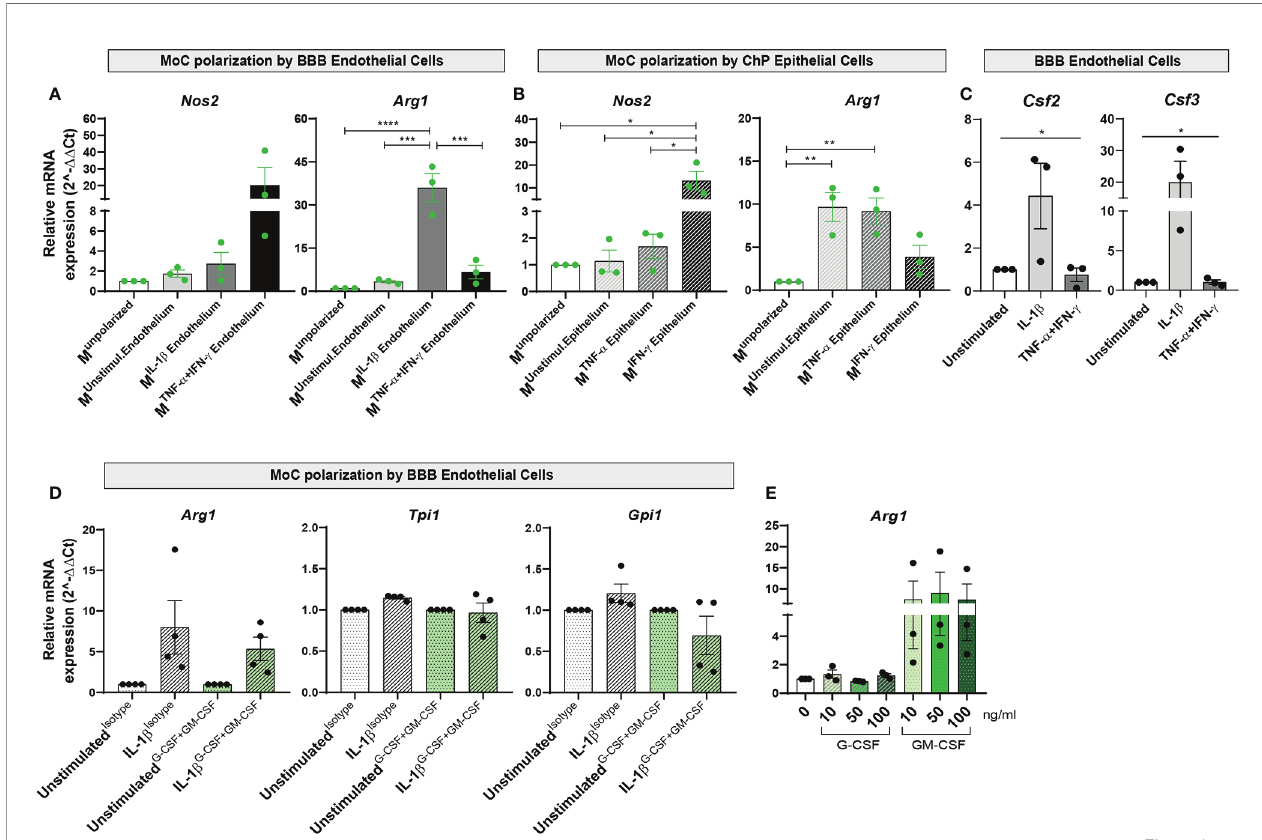
FIGURE 4 | Interaction with BBB endothelial and ChP epithelial cells drives functional speci fi cation in MoCs. Relative mRNA expression of Nos2 and Arg1 genes in M unpolarized MoCs following 7h incubation with (A) BBB endothelial cells and (B) ChP epithelial cells. (A) Incubation with TNF- a +IFN- g BBB endothelial cells led to Nos2 upregulation in MoCs (M unstimul.Endothelium Mean = 1.74, SEM = 0.37; M IL-1 b Endothelium Mean = 2.74, SEM = 1.12; M TNF- a +IFN- g Endothelium Mean = 20.26, SEM = 10.6). In contrast, Arg1 relative mRNA expression was signi fi cantly increased in MoCs incubated with IL-1 b BBB endothelial cells (M IL-1 b Endothelium ) as compared to M unpolarized cells (p < 0.0001), to M unstimulated Endothelium (p = 0.0001) and M TNF- a +IFN- g Endothelium (p = 0.0003). (B) MoCs incubated with IFN- g stimulated ChP epithelial cells (M IFN- g Epithelium ) signi fi cantly upregulated Nos2 relative mRNA expression compared to M unpolarized (p = 0.013), to M unstimulated Epithelium (p = 0.014) and to M TNF- a Epithelium (p = 0.018). Similarly, MoCs incubated with unstimulated ChP epithelial cells (M unstimulated Epithelium) (p = 0.007) or with TNF- a ChP epithelial cells (M TNF- a Epithelium ) (p = 0.01) displayed increased Arg1 mRNA expression. (C) mRNA expression of Csf2 and Csf3 in BBB endothelial cells. Following 16h of IL-1 b stimulation, BBB endothelial cells displayed a signi fi cantly increased Csf2 (one way ANOVA – F (2,6) = 8.97, p = 0.02) and Csf3 relative mRNA expression (one way ANOVA – F (2, 6) = 5.203, p = 0.05) compared to unstimulated and TNF- a +IFN- g BBB endothelial cells. The relative mRNA expression of Nos2 and Arg1 was calculated based on the 2 - DD Ct method using S16 (A, B) or Hprt (C) as reference genes. Data is presented as fold increase relative to M unpolarized condition (A, B) or to unstimulated condition (C) ; displayed are means and SEM from three individual experiments, *p < 0.05, **p < 0.01, ***p < 0.001, ****p < 0.0001. A mean of the raw cycle threshold (Ct) values from the independent experiments performed are provided in Supplementary Table 3 and 4 . (D) mRNA expression of Arg1 , Tpi1 and Gpi1 genes in MoCs following 7h incubation with BBB endothelial cells or ChP epithelial cells in the presence or absence of G-CSF and GM-CSF neutralizing antibodies. G-CSF + GM-CSF neutralizing antibodies (10µg/ml each) or isotype control (20µg/ml) were supplemented to MoCs incubated with BBB endothelial cells or ChP epithelial cells. A non-signi fi cant decrease in Arg1 , Tpi1 and Gpi1 mRNA expression was observed in MoCs following blocking of G-CSF and GM-CSF in IL-1 b BBB endothelial cells (Arg1: IL-1 b Isotype Mean = 7.80, SEM = 3.29; IL-1 b G-CSF+GM-CSF Mean = 5.34, SEM = 1.45; Tpi1: IL-1 b Isotype Mean = 1.15, SEM = 0.02; IL-1 b G-CSF